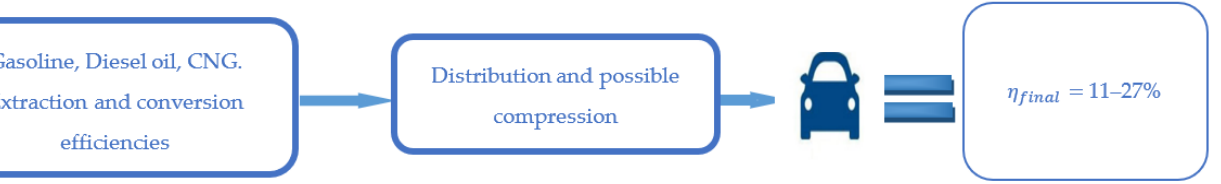
Figure 3. The final efficiency chain of FFVs considering the overall fuel process.